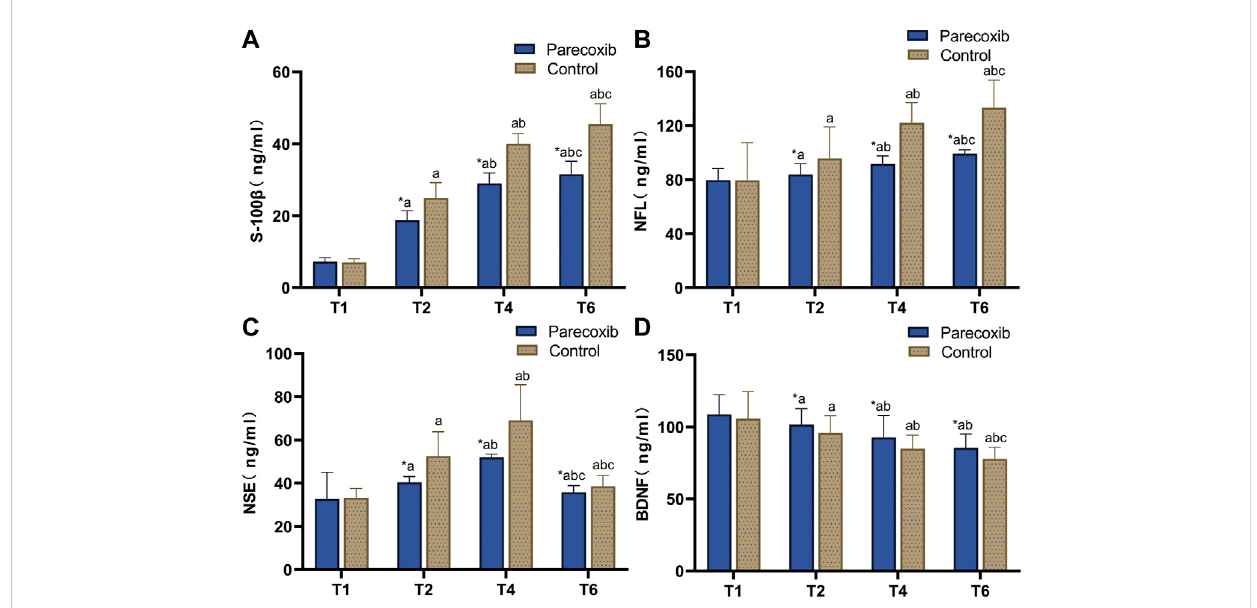
FIGURE 2 Changes of nerve injury related factors S-100 β (A) , NFL (B) , NSE (C) , and BDNF (D) at different time points.